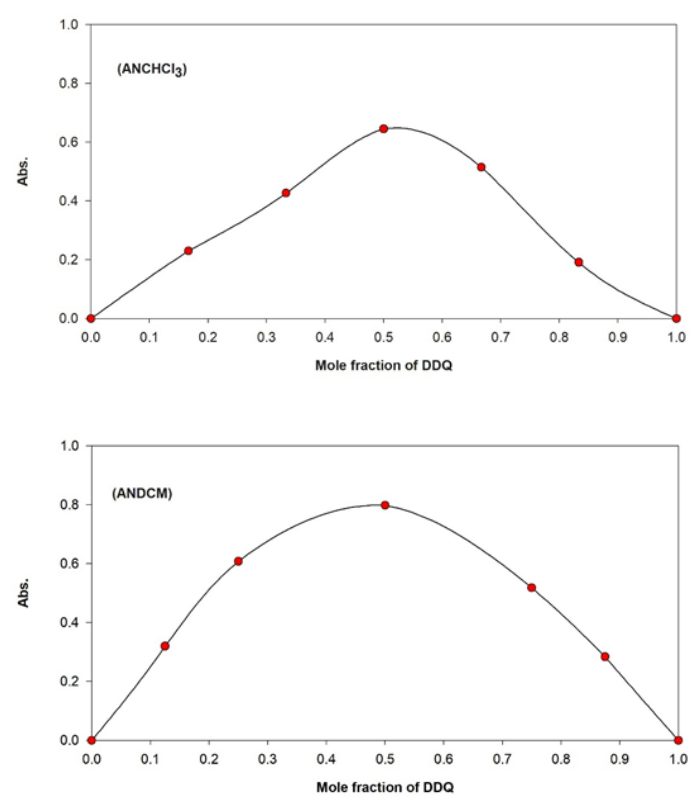
Figure 5. Job ’ s plots of AMFP – DDQ CT complex in different solvents systems. Figure 5. Job’s plots of AMFP–DDQ CT complex in different solvents systems.